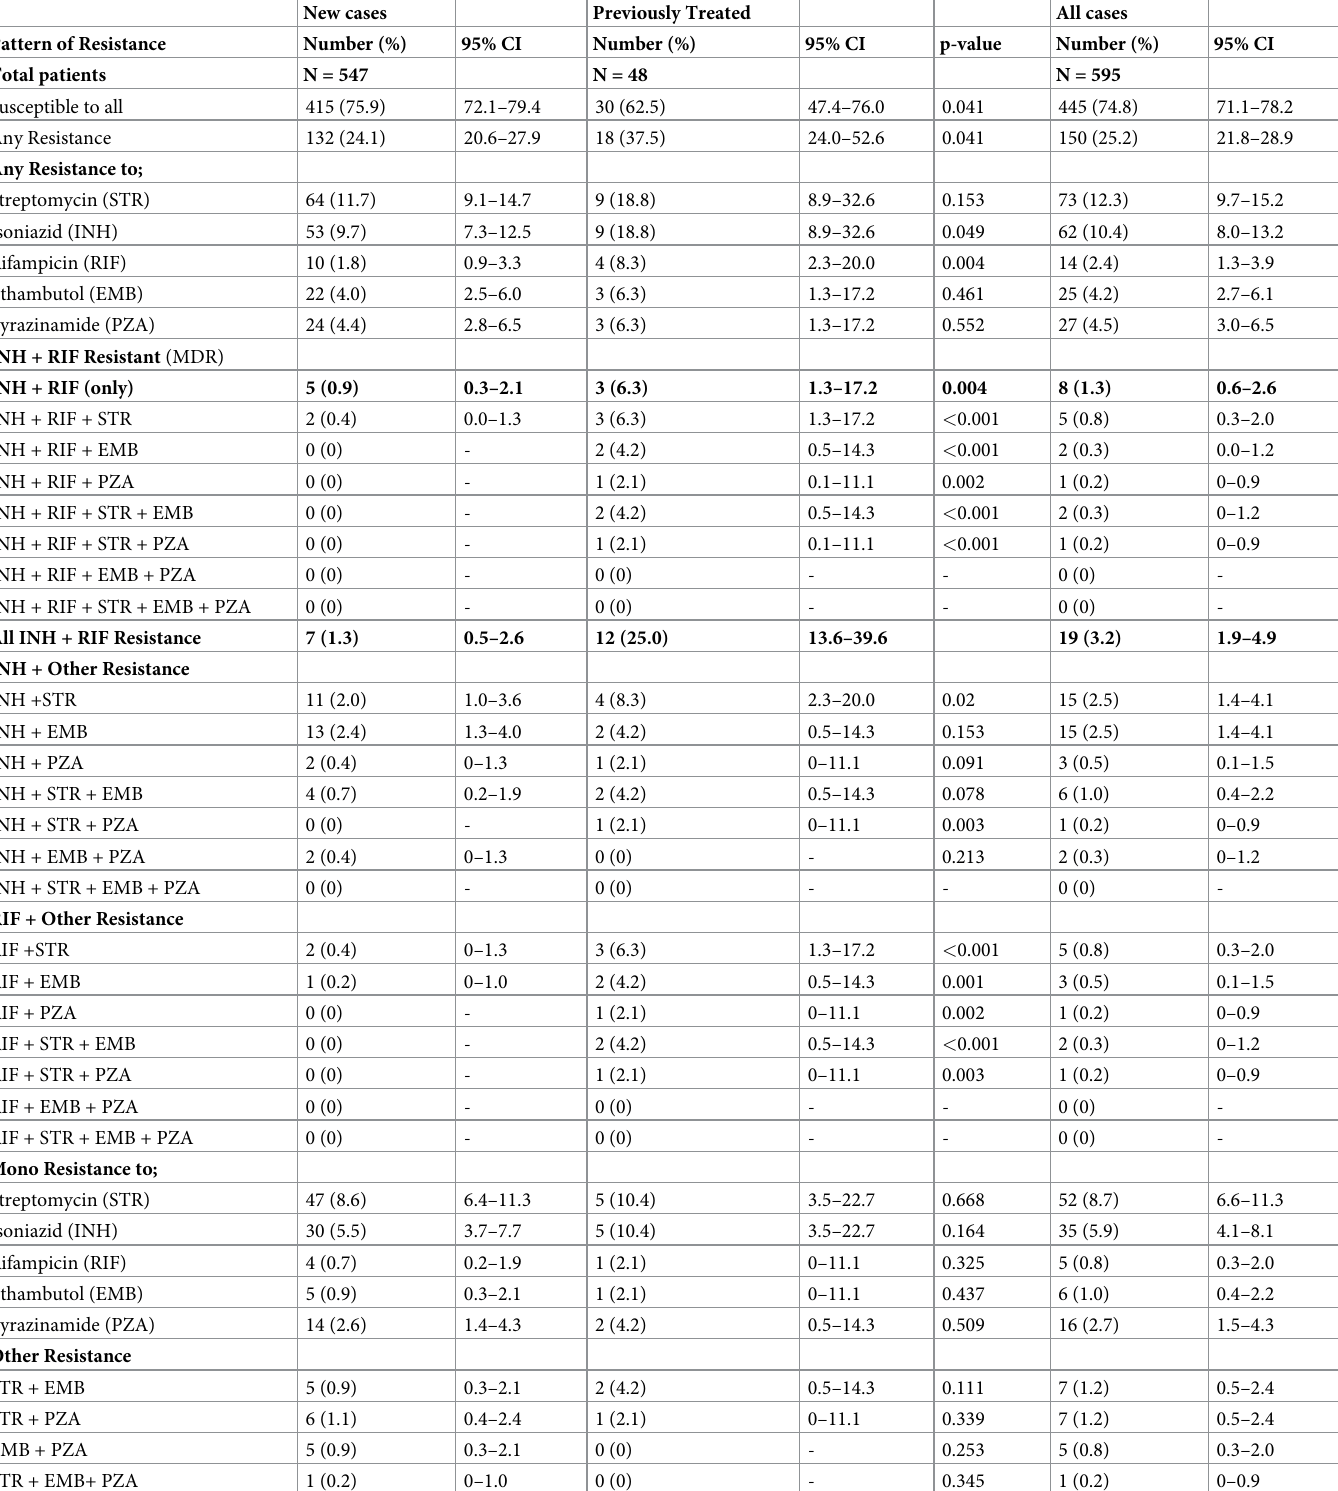
Table 2. Patterns of resistance to TB drugs among new and previously treated sputum smear-positive TB patients in Ghana in